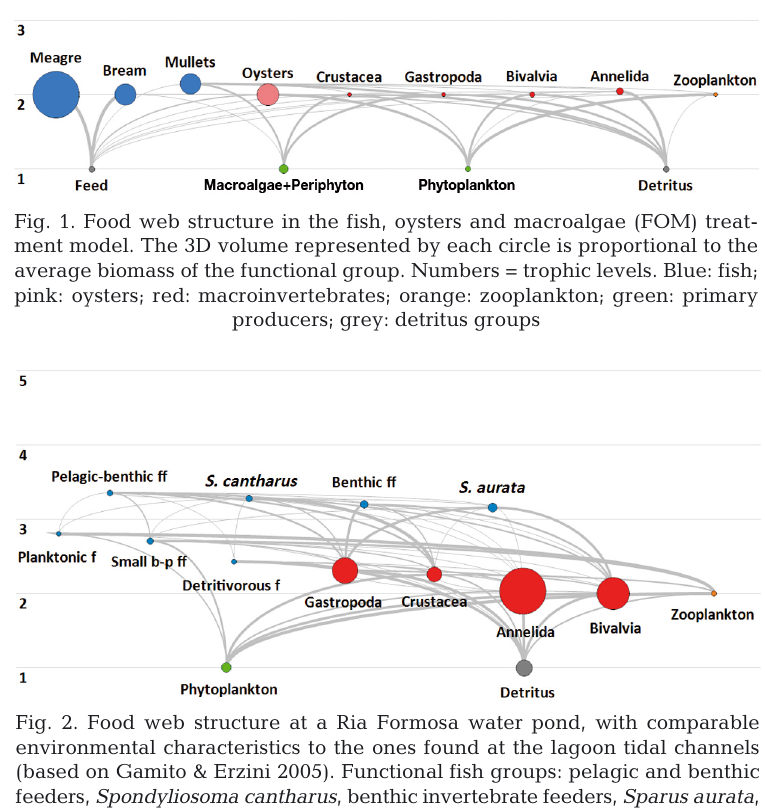
different trophic levels, with high expression on the primary consumers, the benthic invertebrates.